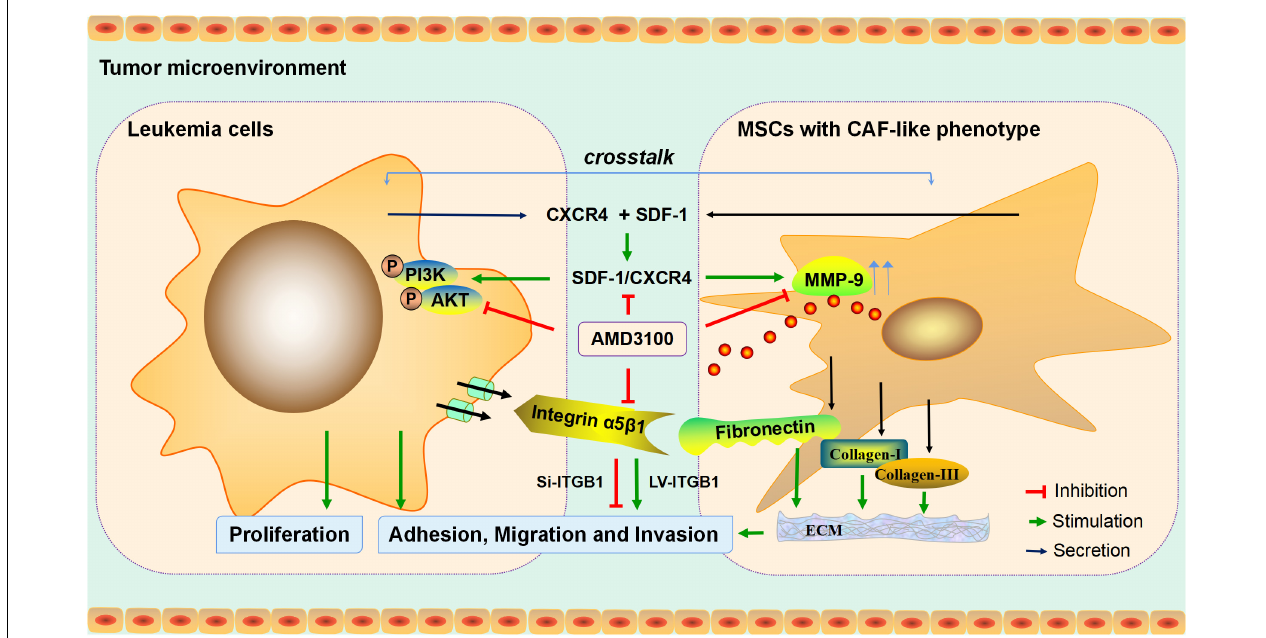
FIGURE 9 | Mechanism diagram. MSCs with CAF-like phenotype stimulate SDF-1/CXCR4 axis to enhance the growth and invasion of B-ALL cells through cell-to-cell communication. AMD3100 reduces the secretion of MMP-9 in MSCs with CAF-like phenotype and the phosphorylation of PI3K/AKT signaling pathway on ALL cells by blocking the SDF-1/CXCR4 axis, and weakens the expression of integrin receptor α 5 β 1 on leukemia cells to reduce the interaction between the integrin α 5 β 1 and the increased secretion of fibronectin in MSCs with CAF-like phenotype, thereby reducing the interaction between MSCs with CAF-like phenotype and ALL cells. Regulation of ITGB1 in leukemia cells could effectively interfere with the promoting effect of MSCs with CAF-like phenotype on the adhesion, migration and invasion of leukemia